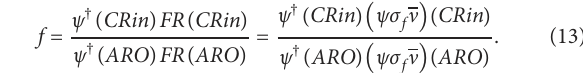
used to determine the reaction rate redistribution factors,